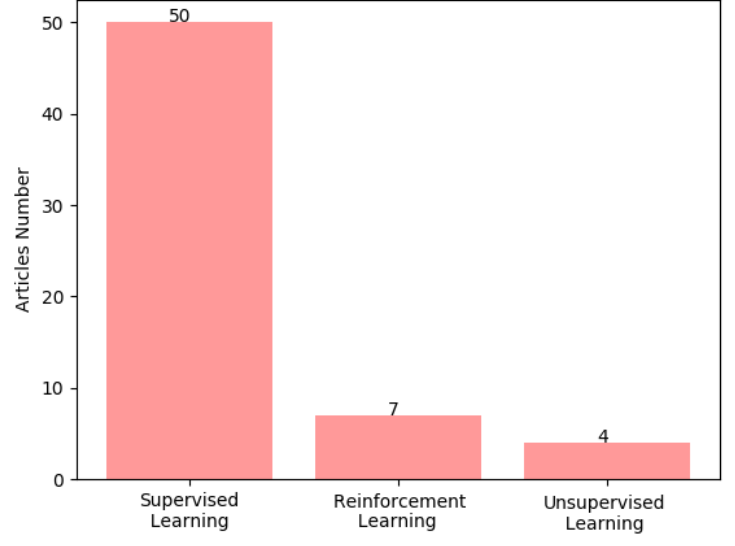
Figure 2. Most common learning type used in the deep learning models for